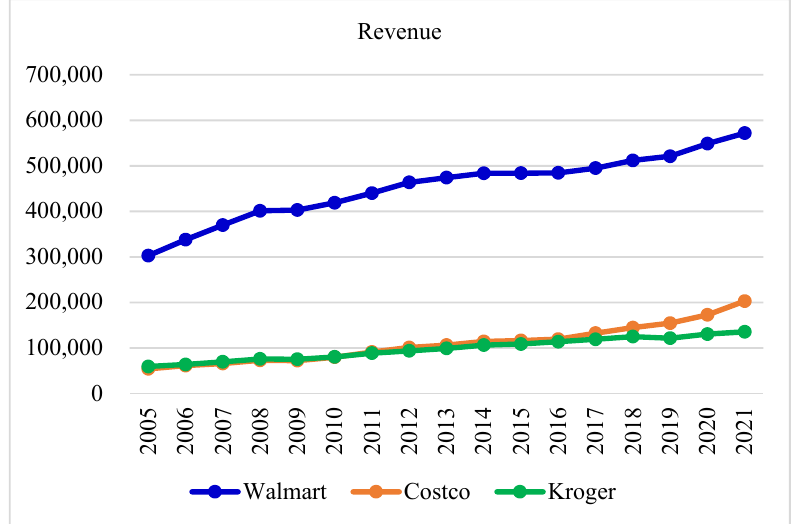
Figure 7. Sales revenues in millions $USD.